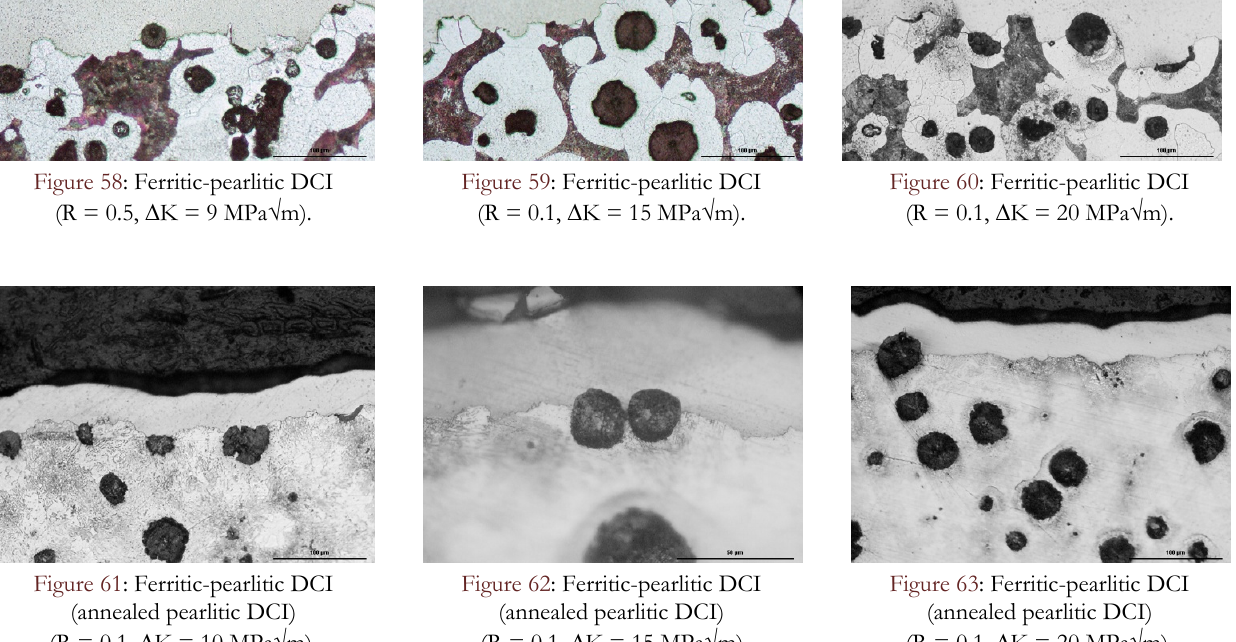
Figure 62: Ferritic-pearlitic DCI (annealed pearlitic DCI) (R = 0.1,  K = 15 MPa √ m).